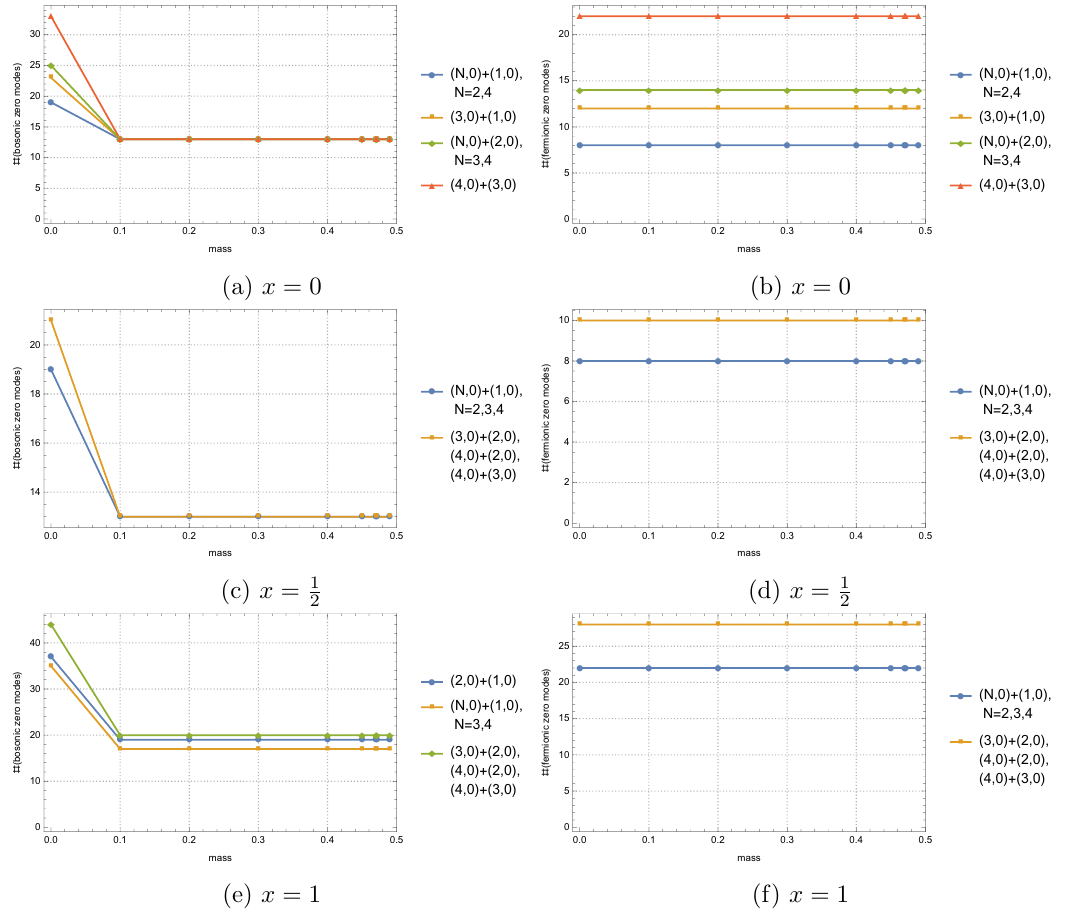
Figure 29. C [( N 1 ; 0)] + C [( N 2 ; 0)] with Higgs con(cid:12)guration (B.15). The number of zero modes in the spectrum of O X + (cid:30) is shown in (a), (c), and (e), while the number of zero modes of =D X + (cid:30) are V displayed in (b), (d), and